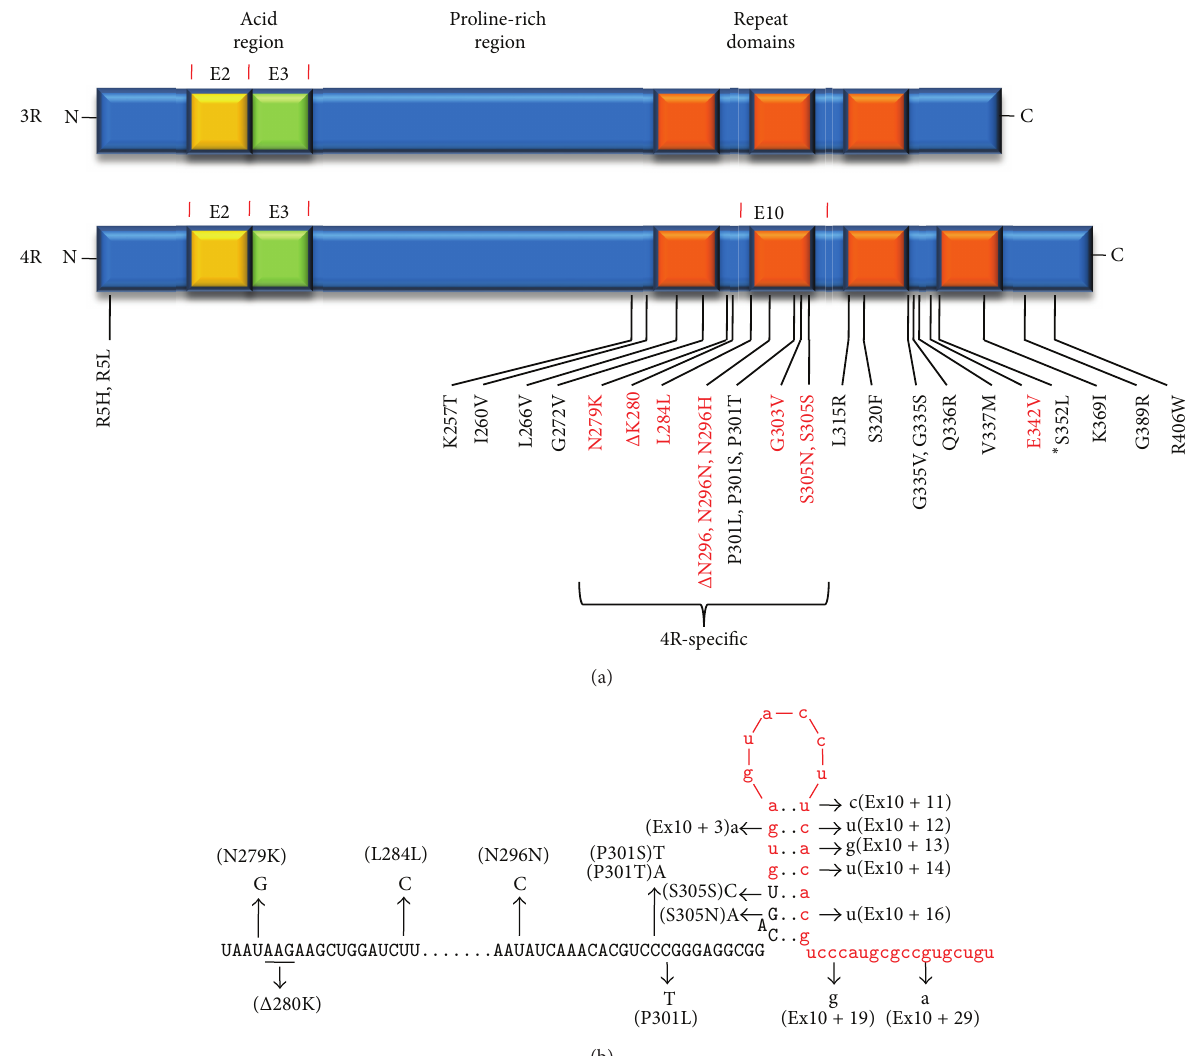
Figure 1: Tau splice isoforms, mutations, and splicing. (a) Alternative splicing of exon 10 results in tau isoforms with either 3 or 4 microtubule- binding repeat domains (3R or 4R tau). Alternative splicing of exons 2 and 3 is not shown. Site of FTLD-associated exonic mutations is indicated. Some of these mutations are silent and/or alter exon 10 splicing (red). Some of these mutations are also specific for the 4R isoforms of tau (bracket). (b) Stem-loop structure at the junction between exon 10 and intron 10. Site of FTLD-associated mutations in this structure destabilizing the stem-loop, increasing access to splicing factors and exon 10 inclusion, and resulting in increased 4R over 3R tau